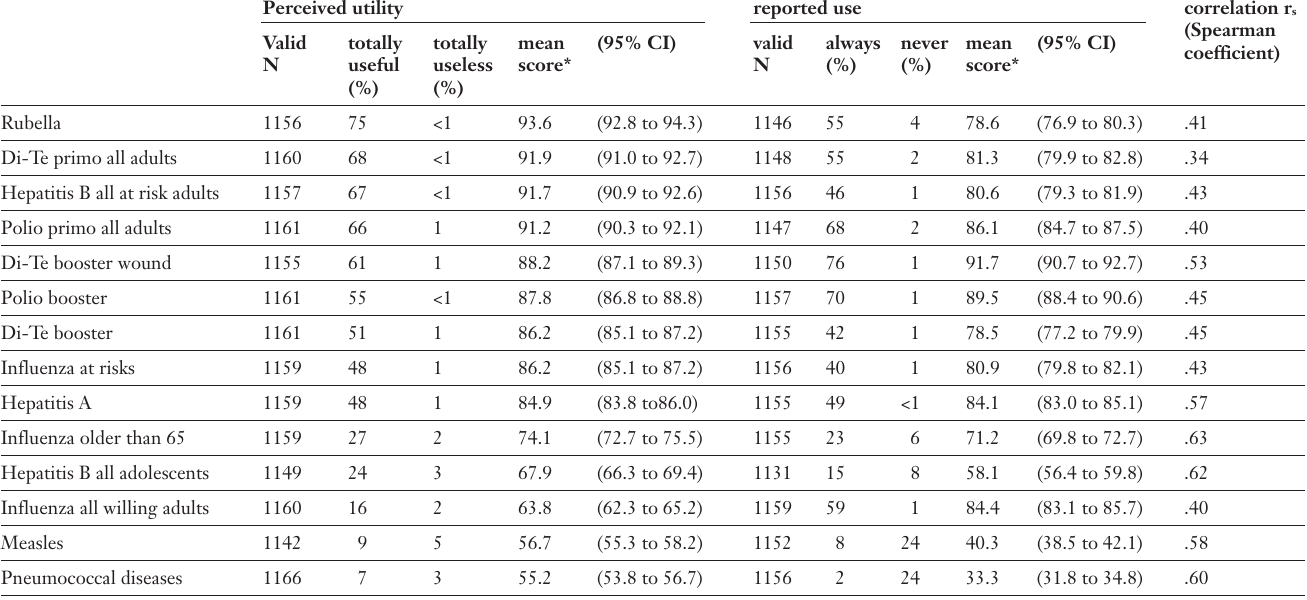
Relations between opinions about the use of adult vaccina- tions and overall score of utility of recommended adult vaccinations among 1166 non-paediatric Swiss primary care